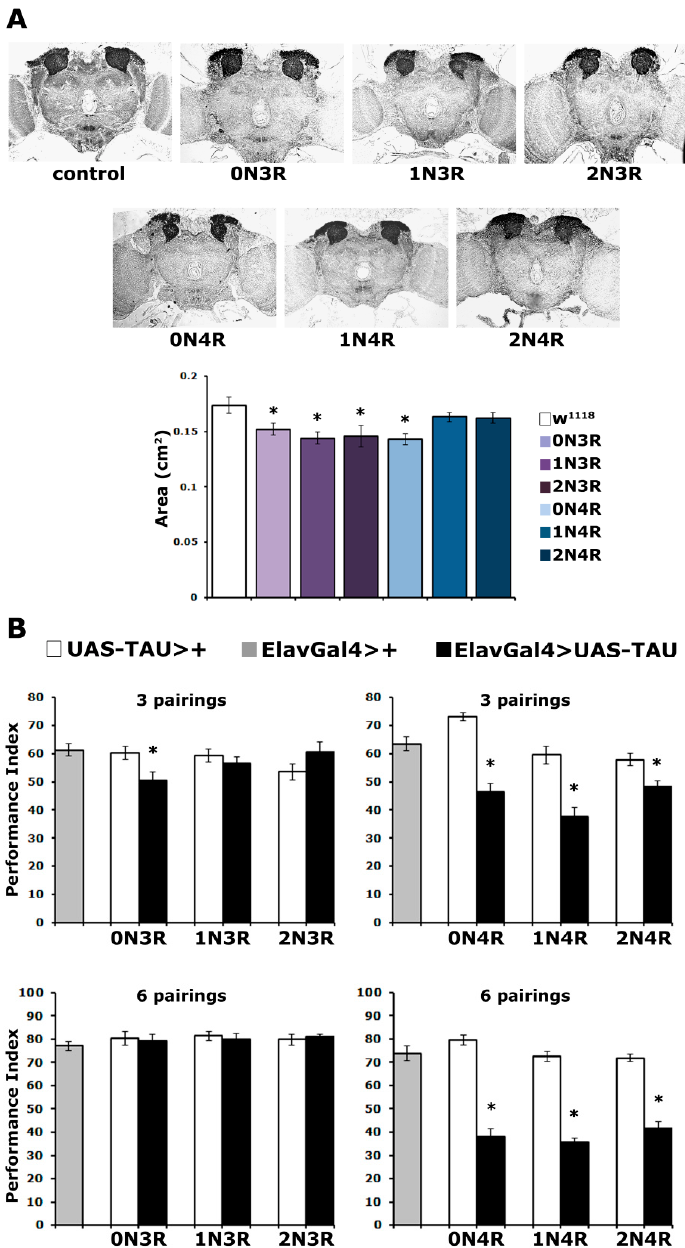
Figure 2. Tau isoforms affect differentially mushroom body neurons structurally and functionally. ( A ) Carnoy’s-fixed paraffin-embedded frontal sections stained with anti-Leonardo antibody at the level of the dendrites (calyces) of MB neurons, from control (elavGAL4/+) and animals expressing the indicated hTau transgenes under elavGal4. The area of the calyx from multiple similar sections per genotype was quantified, averaged below and presented as the mean ± SEM. Stars indicate significant differences from control flies. n ≥ 7 for all genotypes. ( B ) Learning after 3 and 6 pairings of animals accumulating pan-neuronally the indicated hTau transgenes under elavGAL4 (black bars) compared with driver (grey bars) and transgene heterozygotes (white bars). The means ± SEMs are shown. Stars (*) indicate significant differences from both controls. n ≥ 11 for all genotypes. Statistical details for both experiments are presented in Supplemental Table S2.